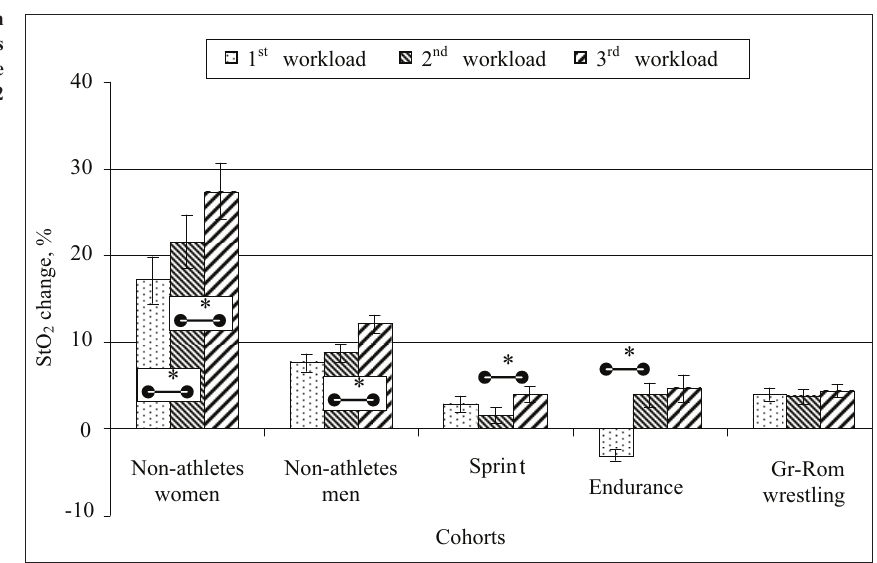
Figure3. Level of oxygen saturation (StO 2 ) in thigh muscles (m. vastus lateralis) before the next testing procedure or 2 minutes after